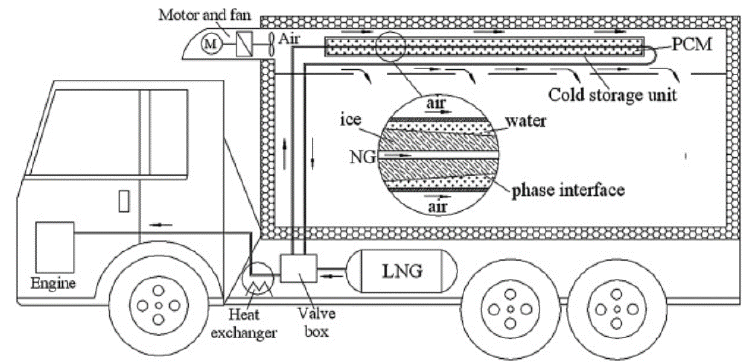
Figure 17. PCM refrigeration schematic illustration [179].